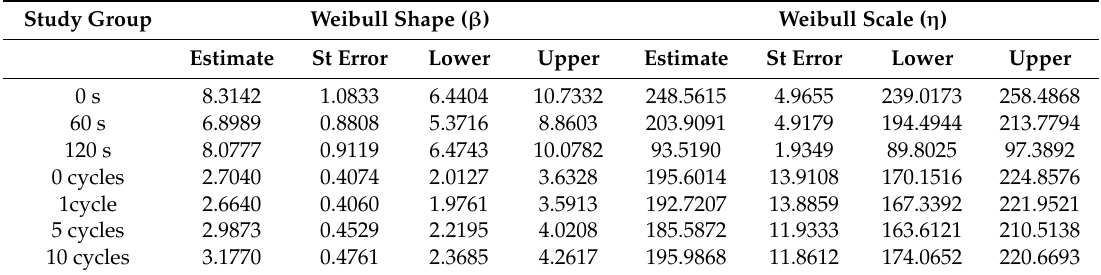
Table 2. Weibull statistics of time to failure for the time of use and the sterilization cycles study groups.